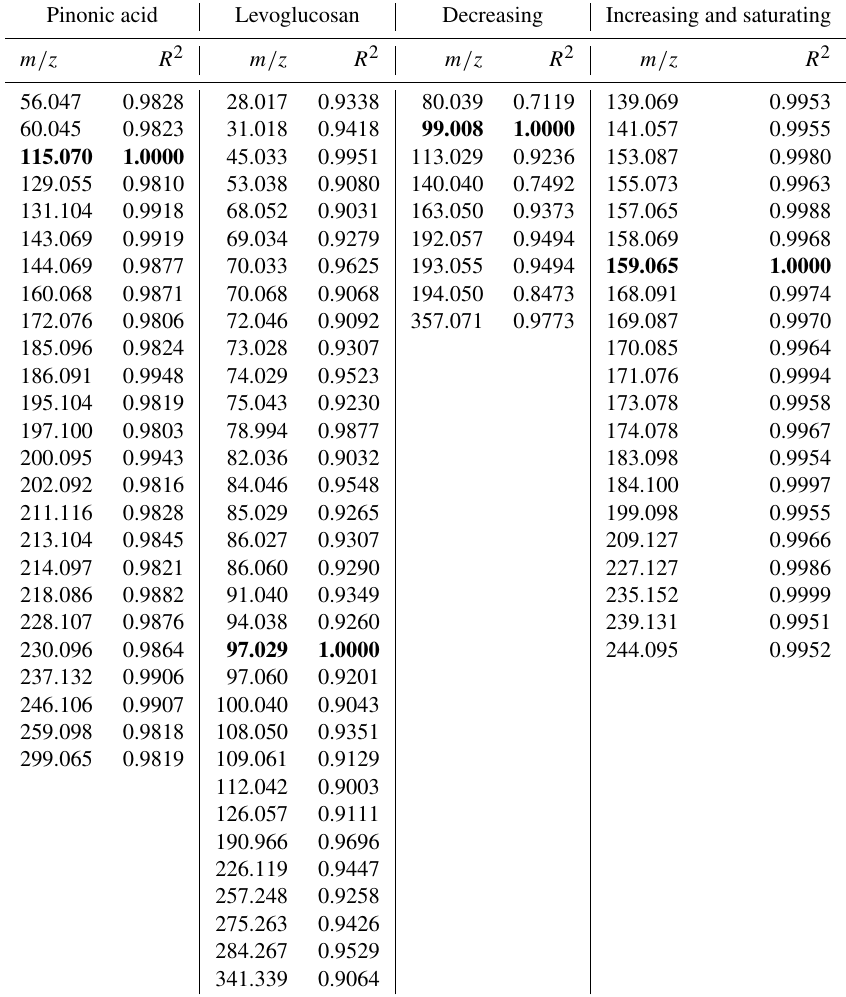
Table A1. Groups of ions as identified using a linear regression model. Note that different thresholds and cutoffs of R 2 values are used to assign different ions to the groups (cutoffs: R 2 > 0 . 98, 0.98, 0.995, and 0.70). The ions used for the group identification are highlighted in